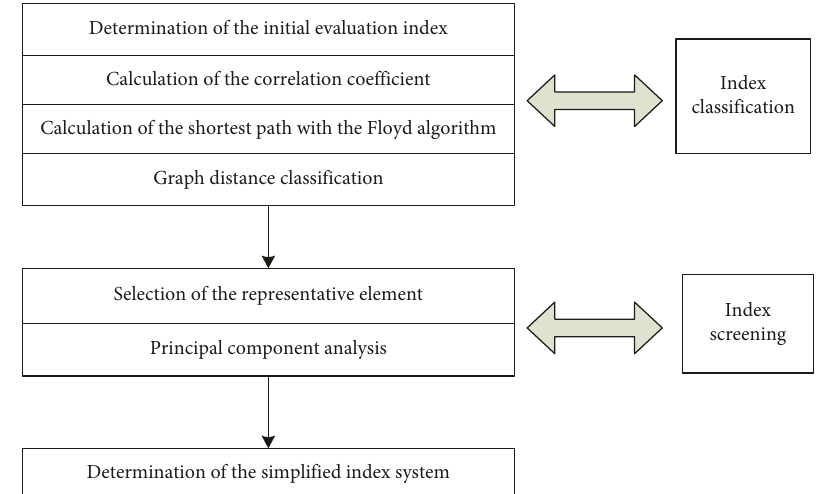
Figure 1: Flow chart for the construction of the index